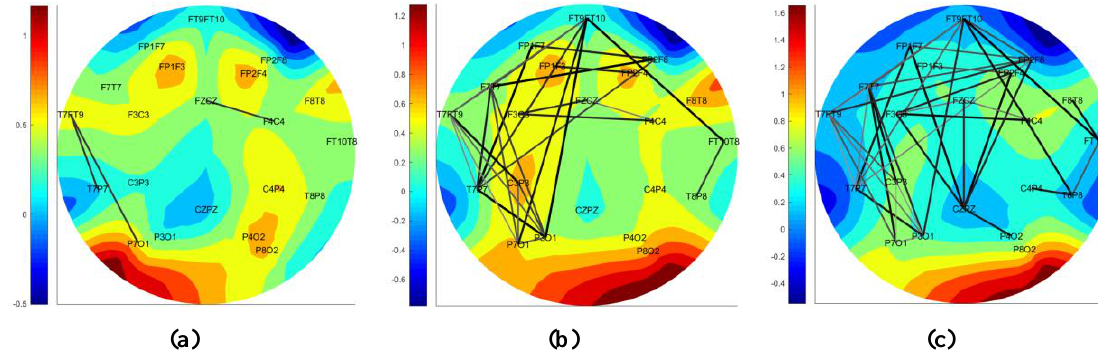
Figure 3. The transition of the distance network (DN) from preictal to ictal. DN networks of ( a ) an epoch before the seizure, ( b ) beginning of the seizure, and ( c ) an epoch after the seizure start. The DNs indicate the increase in closeness and model a spreading seizure in the brain.